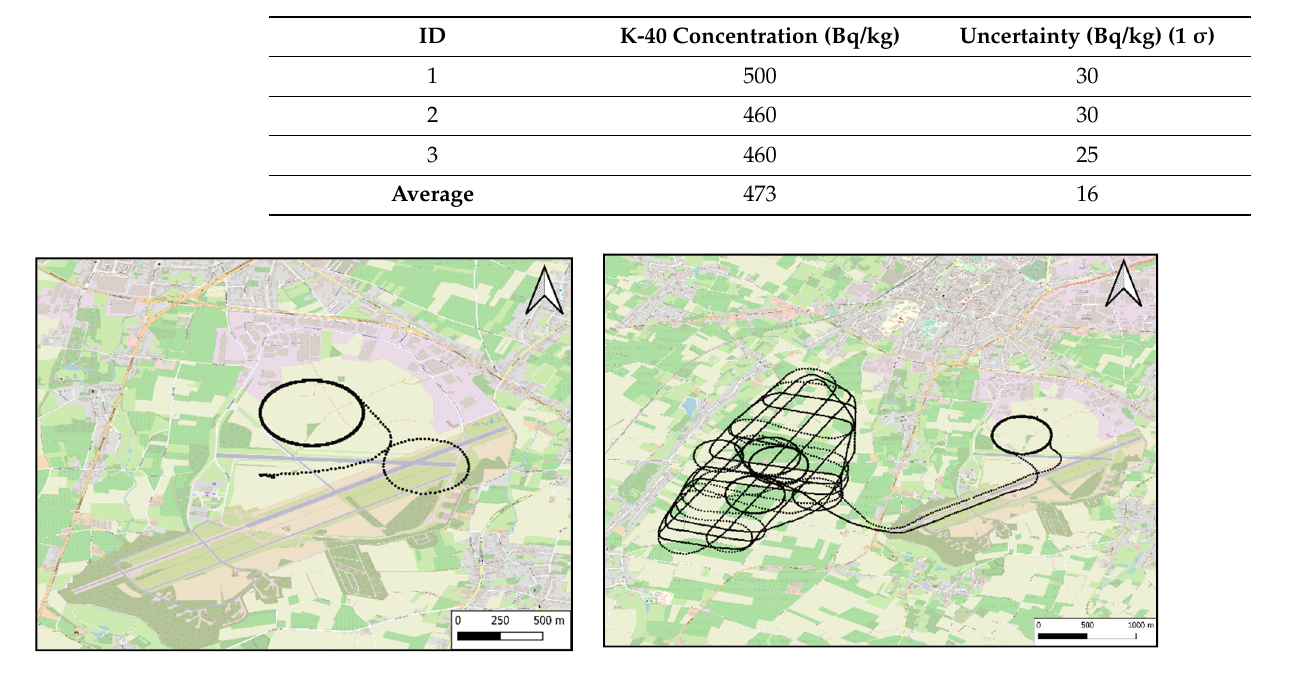
Table 2. Table with sampled concentration data and their uncertainties.